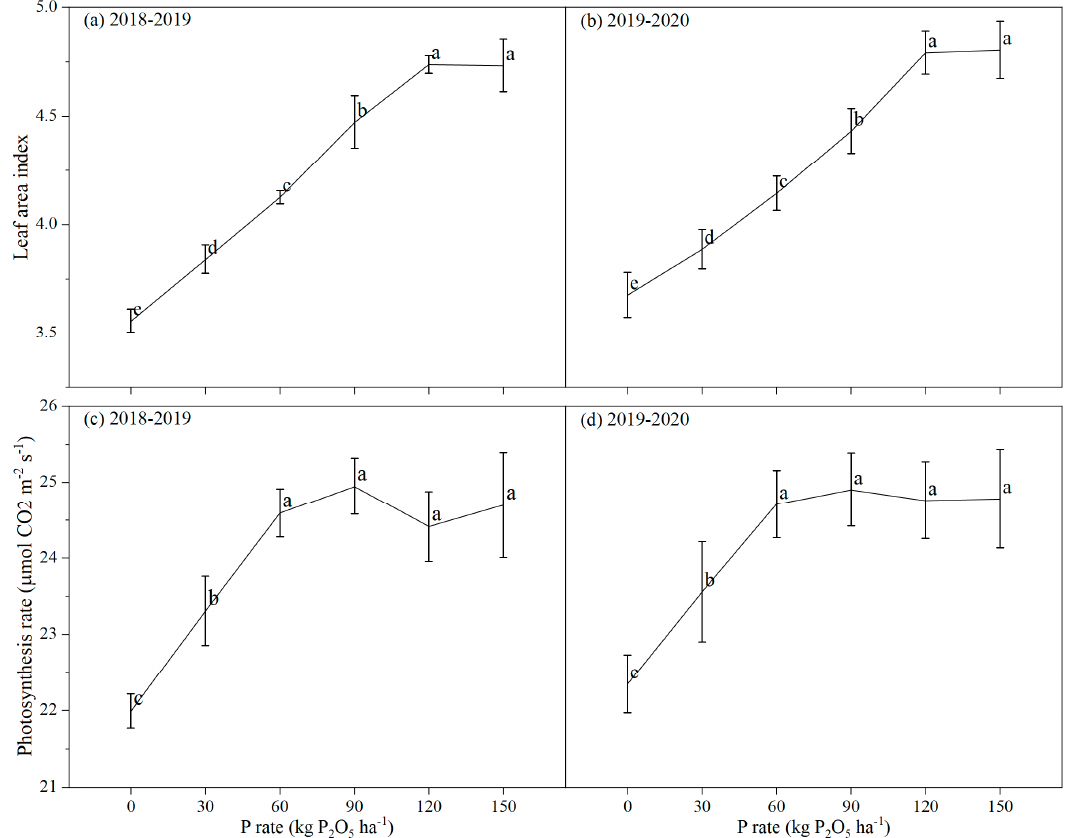
Figure 4. Effects of P rate on leaf area index and photosynthetic rate of canola plants in a saline environment. ( a , b ): leaf